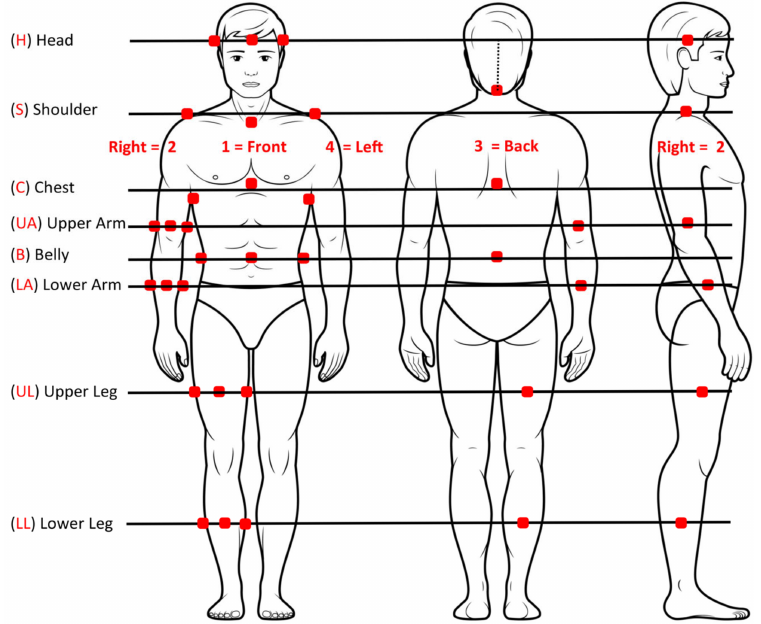
Figure 2. The figure shows the location of the 31 dosimeters. H: head; S: shoulder/neck; C: upper chest; B: belly level; UA: upper arm; LA: lower arm; UL: thigh; LL: lower leg. In general, the dosimeters covering the standing person are placed pointing in four directions in a horizontal plane. (1 = front; 2 = right; 3 = back; and 4 =